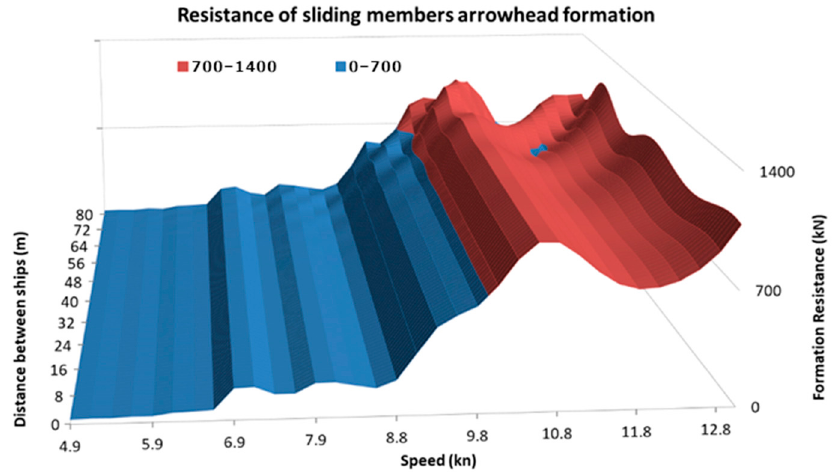
Figure 14. Total resistance of a formation composed of four tugboats sailing in a diamond-shaped formation.